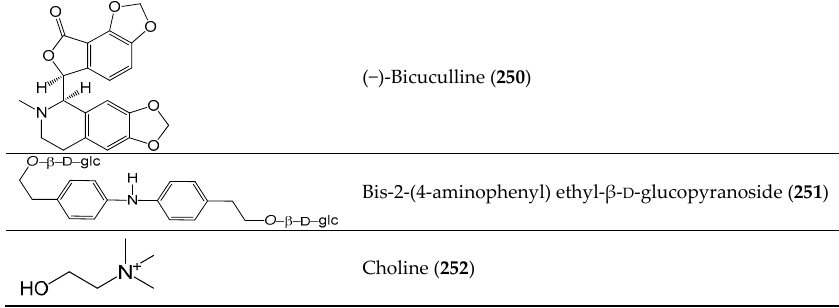
Figure 7. Chemical structures of alkaloids in Forsythiae Fructus.